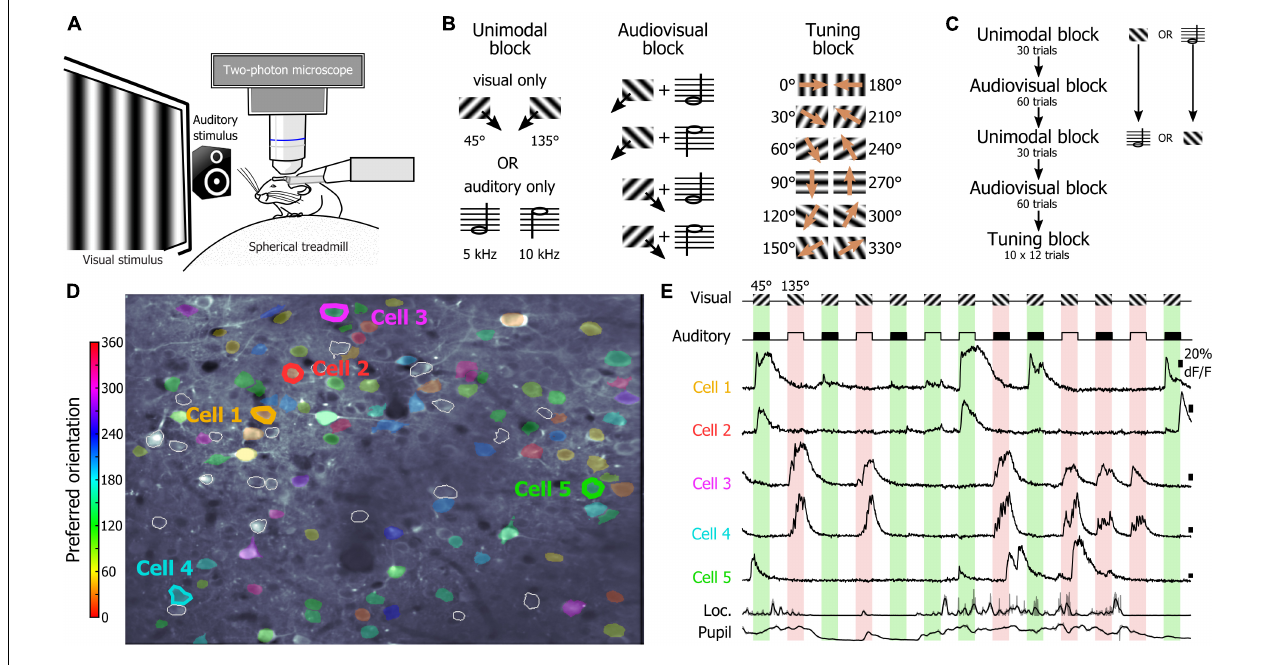
FIGURE 1 | Recording sessions in naïve mice. (A) Schematic representation of the recording setup. (B) Stimuli presented during the unimodal, audiovisual, and tuning blocks. (C) Organization of the unimodal, audiovisual, and tuning blocks in a recording session. (D) Two-photon image of V1 neurons recorded in a naïve mouse. The preferred orientation of the segmented neurons is indicated by the color scale in inset. White contours indicate segmented neurons that were not estimated orientation selective by the algorithm. (E) Example of the activity of neurons indicated in panel (D) during the presentation of the visual stimuli of the audiovisual block. The neuronal activity was recorded simultaneously with the locomotion of the animal as well as the pupil size (bottom